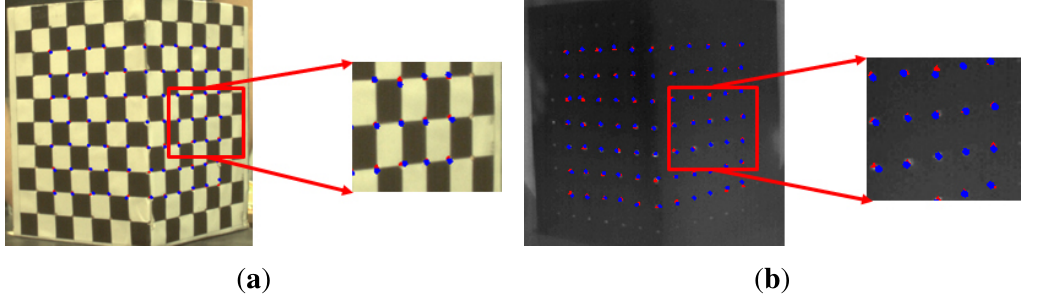
Figure 15. Re-projection error between projected 2D coordinates from 3D points and 2D points extracted from the ( a ) visual image and ( b ) thermal-IR image. The red and blue points represent extracted 2D points and projected 2D points,